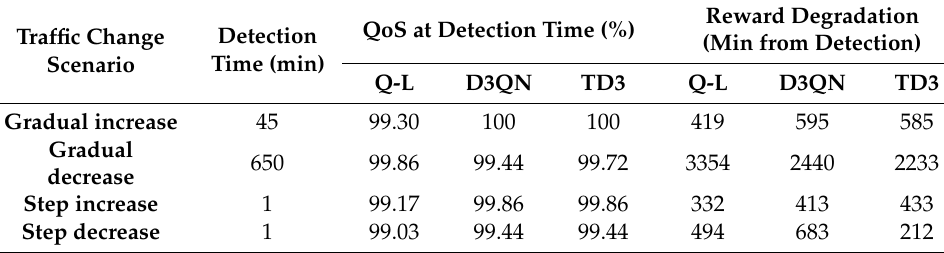
Table 4. Phase III: Analysis under traffic changes.